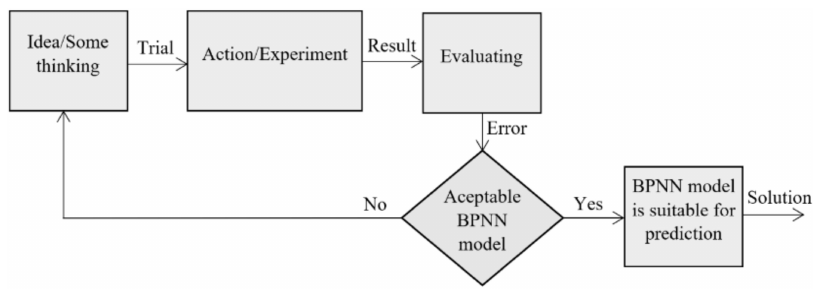
Figure 1. Trial-and-error